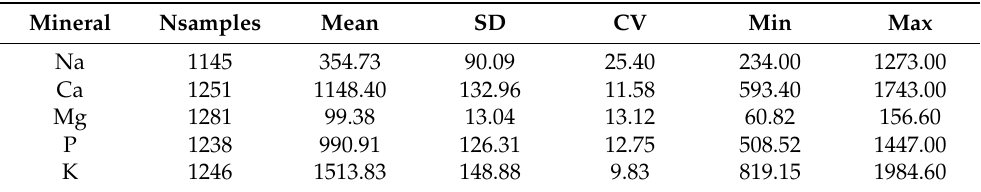
Table 2. Descriptive statistics value calculated from reference content (mg/kg of milk) analyzed in